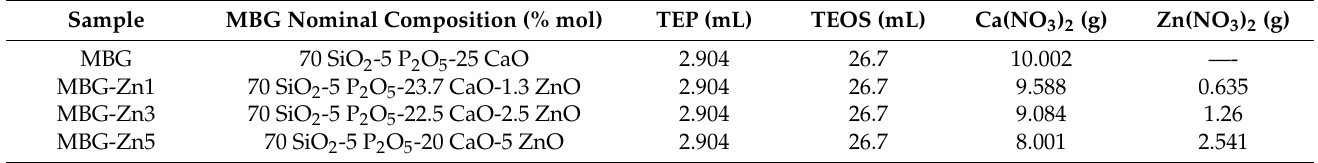
Table 3. Amounts of reagents used during synthesis of the